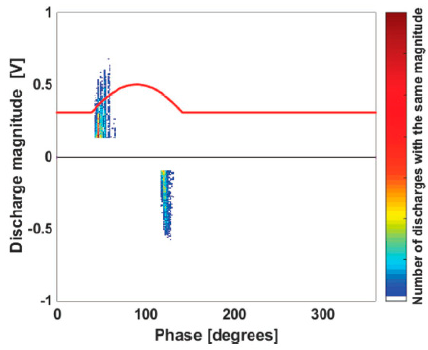
Figure 18. The internal PD pattern acquired using the continuous periodic DC waveform.